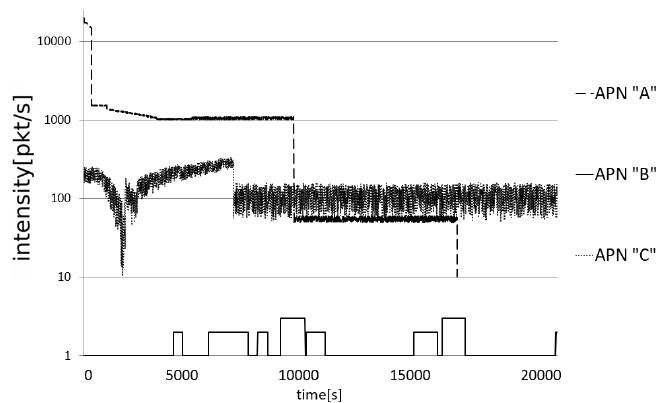
Figure 15. Signaling intensity for APN A (dash), APN B (line), APN C (dotted) [31].